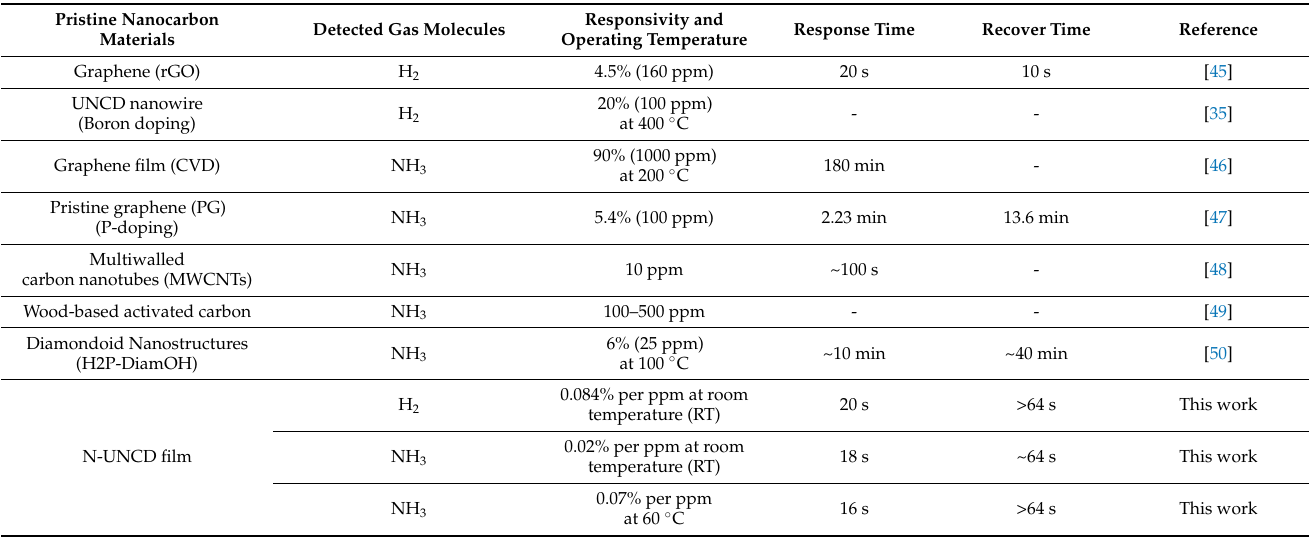
Table 1. Comparison of the performance on gas sensing of the recently published pristine nanocarbon based